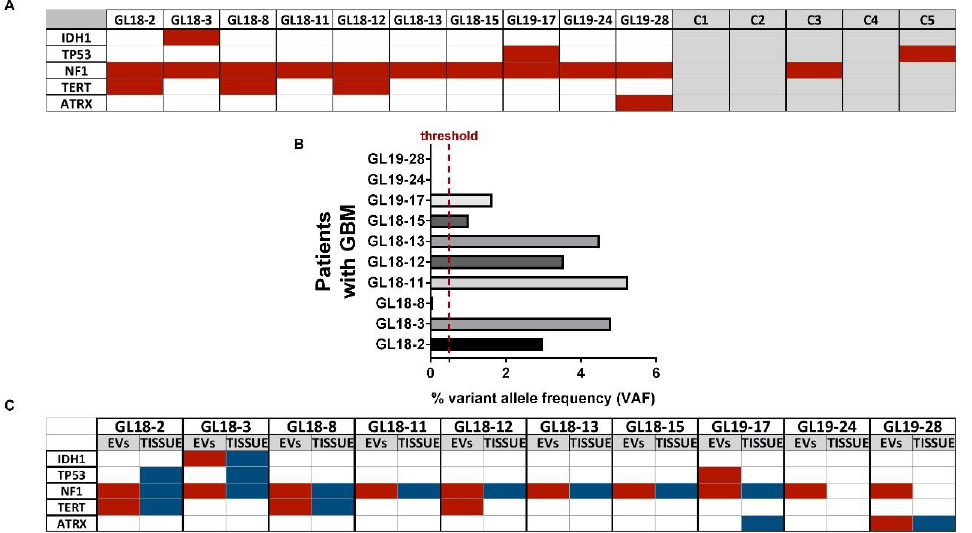
Figure 2. ( a ) Comparative analysis of pathogenic mutations (highlighted in red) found in peripheral- blood-derived EVs of patients with glioblastoma ( n = 10) and healthy donors ( n = 5). Acronyms GL18-2/19-28 and C1-C5 indicate patients and controls, respectively. ( b ) Variant allele frequency (VAF, expressed as percentage) of the pathogenic variant c.2568C>G of the NF1 gene in blood-de- rived EV of patients ( n = 10). A >0.5% VAF cut-off threshold was set. Results are expressed as the mean ± SD. ( c ) Comparative analysis of pathogenic mutations (highlighted in red) found in periph- eral-blood-derived EV and matched cancer tissue (highlighted in blue) of patients with GBM ( n = 10). Acronyms GL18-2/19-28 and C1-C5 indicate patients and controls, respectively. Table 4. Genomic variants with pathogenic significance found in blood-derived EV of the 10 pa- tients with grade 4 glioblastoma.